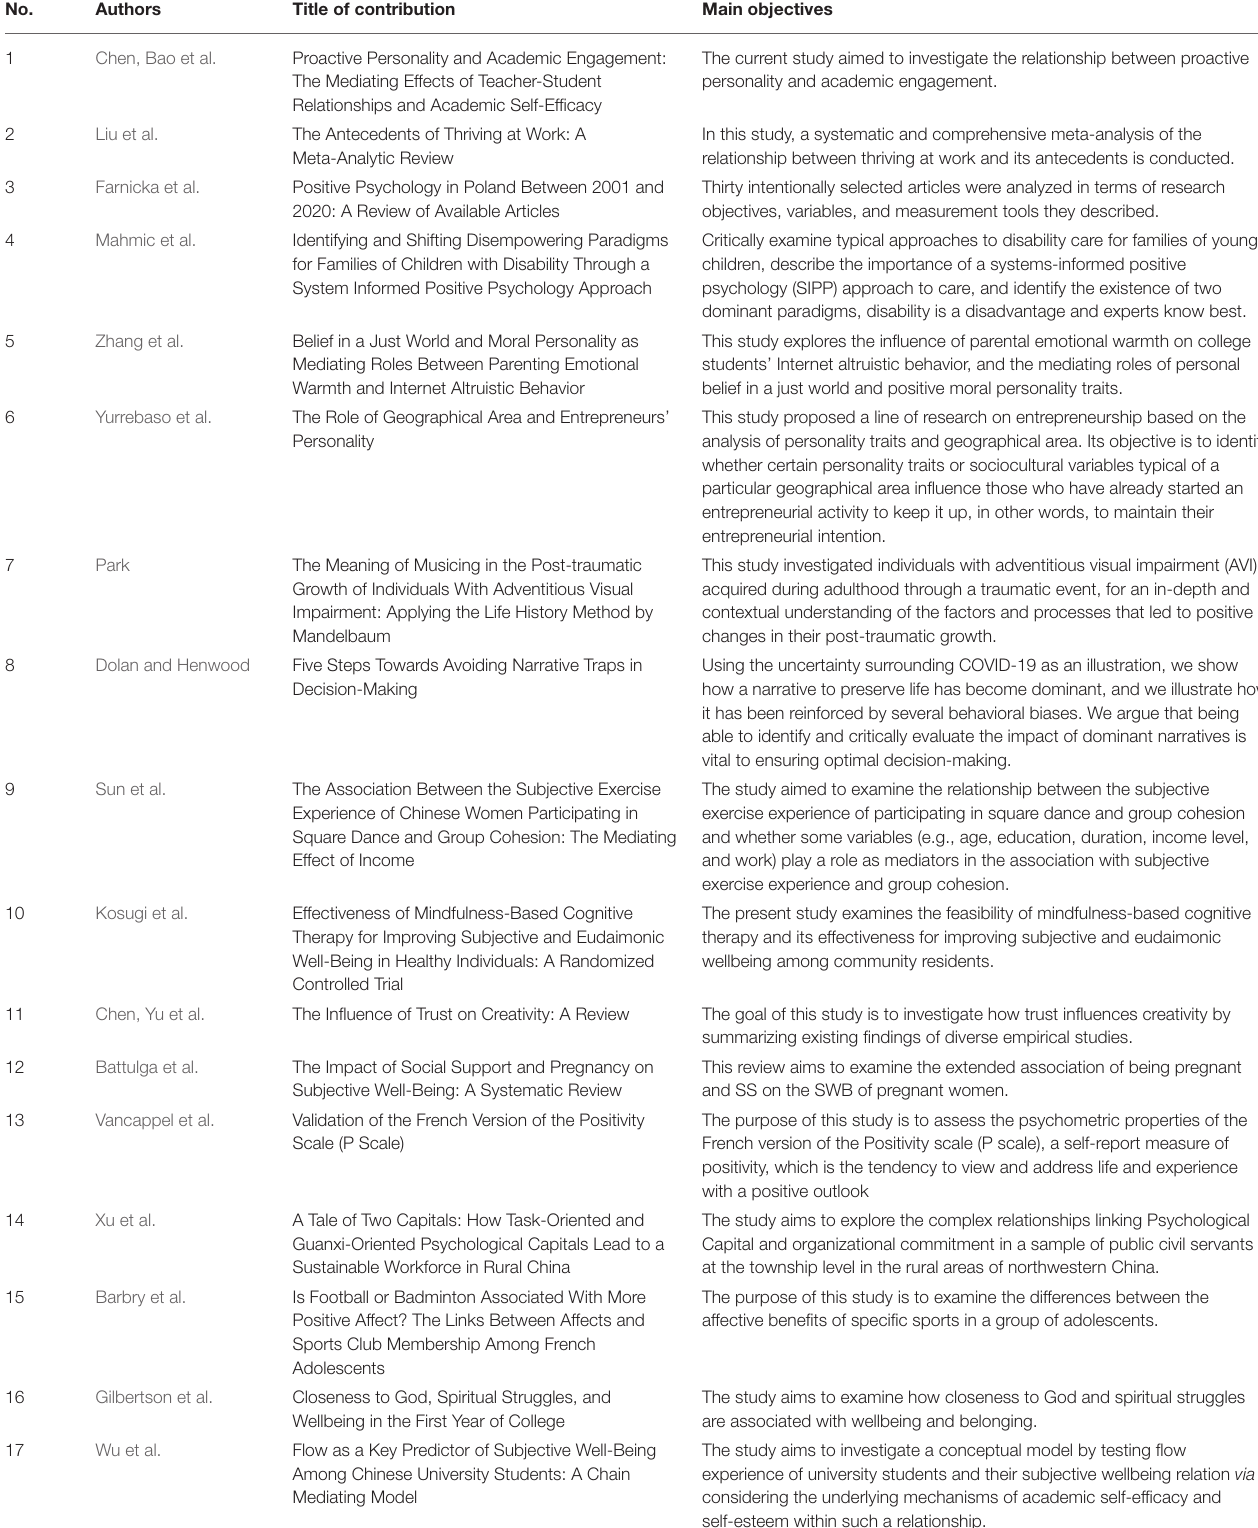
TABLE 1 | Summary of the contributions to this Research